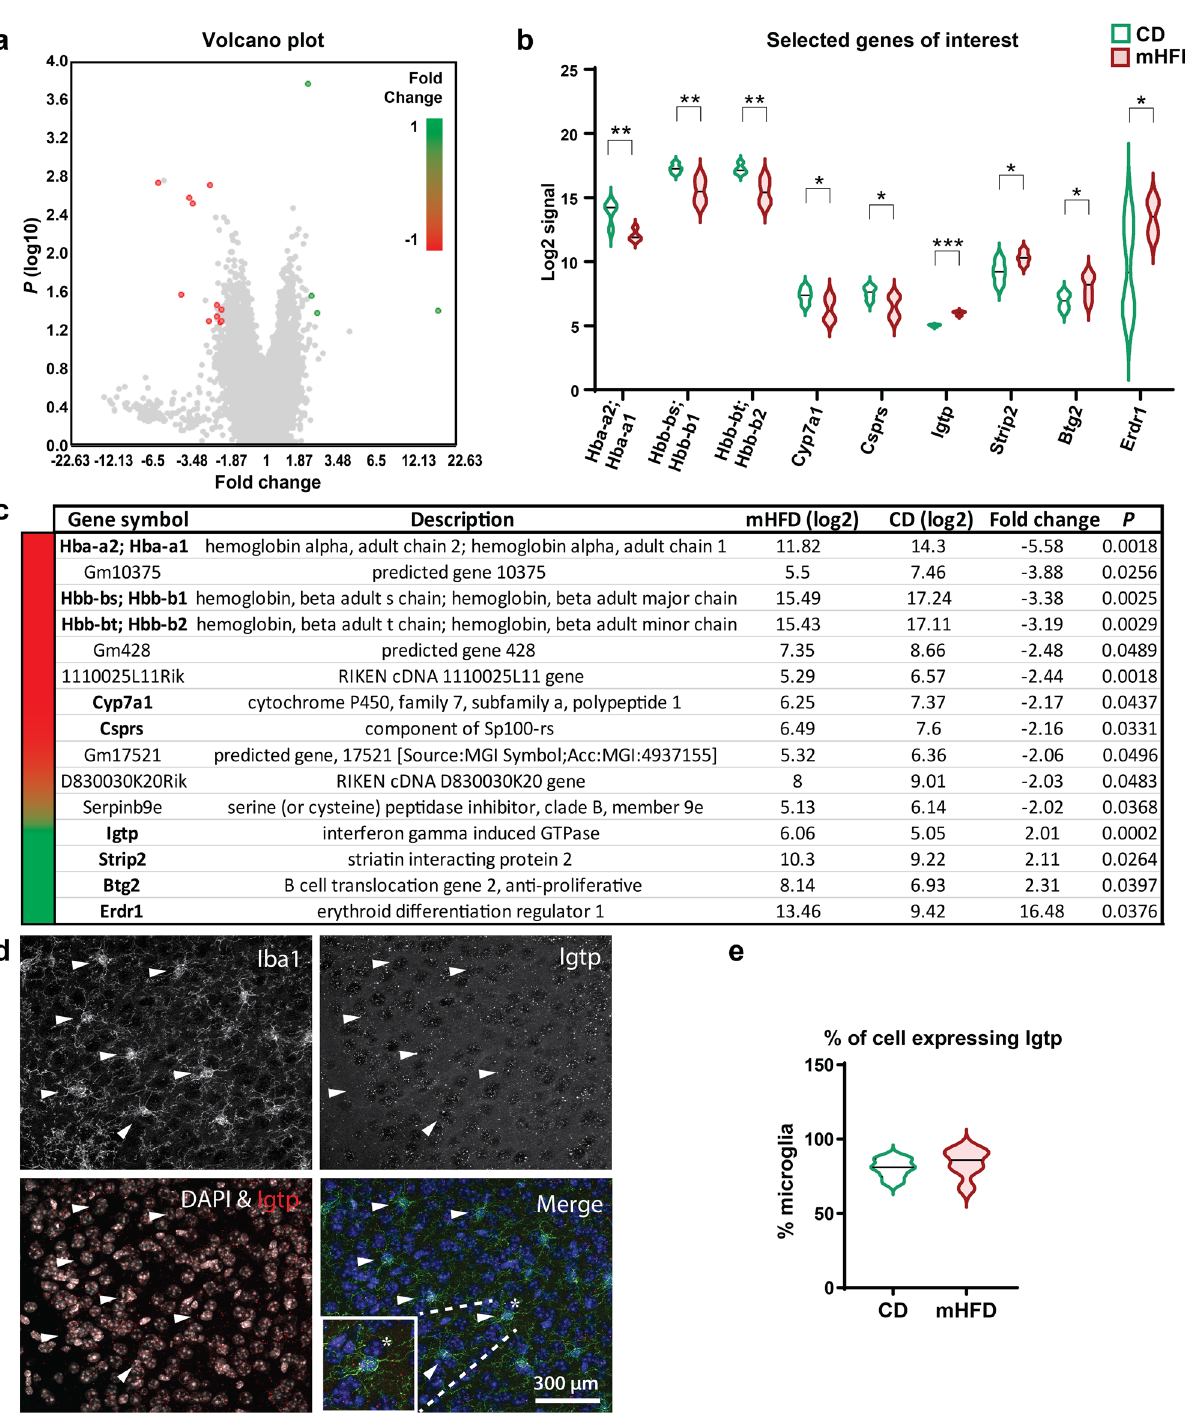
Fig. 4 RNA microarray reveals differential expression of 15 genes in the cortex of P30 offspring exposed to mHFD, regardless of their sex. a Volcano plot of P value versus fold change help visualise 15 genes with differential expression; four upregulated and eleven downregulated on whole-genome after mHFD. b Selected genes of interest include genes of the haemoglobin pathway ( Hba-a2;Hba-a1 , Hbb-bs;Hbb-b1 , Hbb-bt;Hbb-b2 , Erdr1 ), cytochrome P450 pathway ( Cyp7a1 ), immunity ( Csprs , Igtp ), cytoskeleton ( Strip2 ) and tumour suppressors ( Csprs , Btg2 ). c Exhaustive table of differentially expressed genes with relative expression, fold change and P value are detailed in the bottom part ( n = 4 animals/diet). d FISH-immuno fl uorescence allowed us to visualise Igtp (in red), the most affected gene, expressed in Iba1 + microglia (in green) within their nucleus (DAPI in blue). Igtp -positive Iba1 + cells are indicated by white arrowheads. e Percentage of microglia expressing Igtp per animal was calculated ( n = 6 animals/diet). Males and females are grouped together since no sex differences were found for the cerebral cortical vasculature. Violin graphs show minimum, median (black line) and maximum. * P < 0.05, ** P < 0.01, *** P < 0.001 by empirical Bayes statistical analysis for differential expression. CD: control diet, FISH: fl uorescence in situ hybridization, mHFD: maternal high-fat